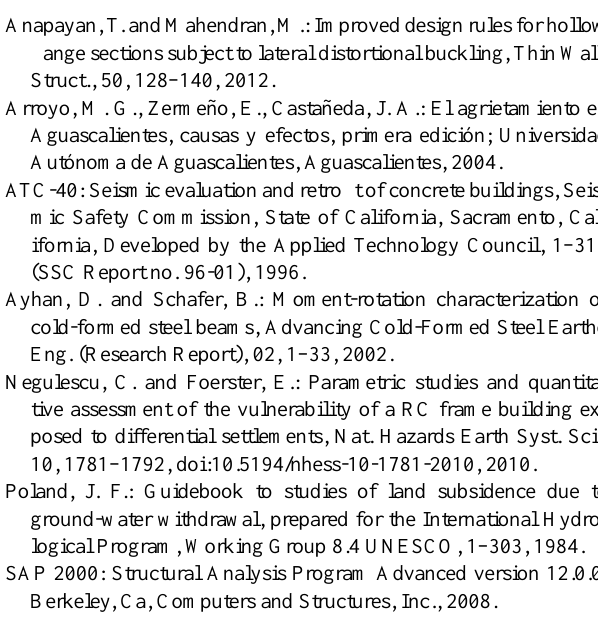
Figure 4. Excessive deformations in bottom track and fail of